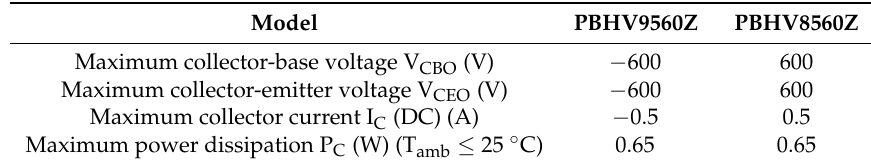
Table 2. Absolute maximum ratings of Emitter Follower